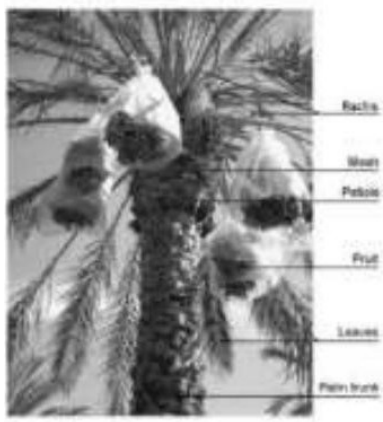
Figure 2. Date Palm Main Components